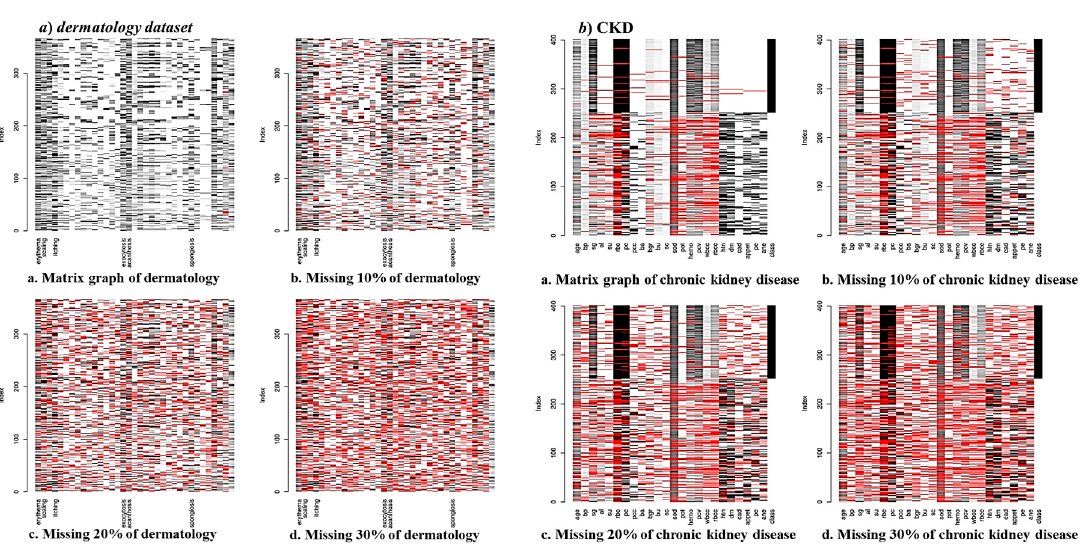
Figure 6. Experimental results of a user-based collaborative filtering model.